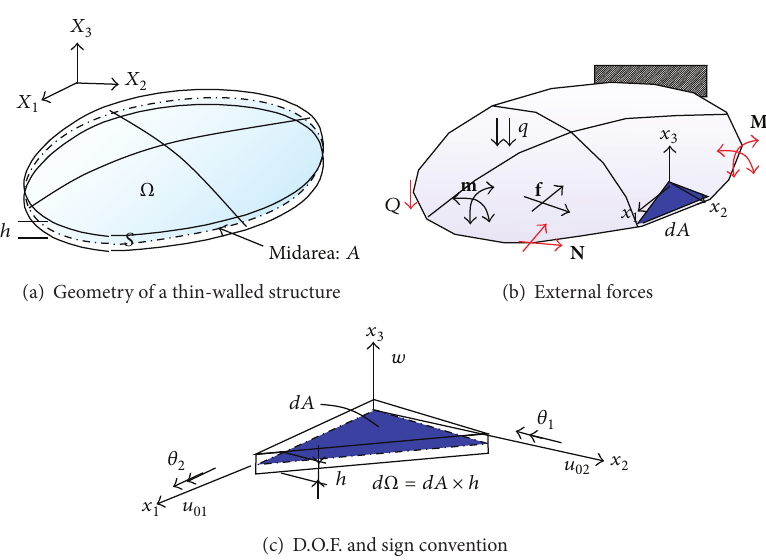
Figure 1: Geometry of a thin-walled structure consisting of infinitesimal flat